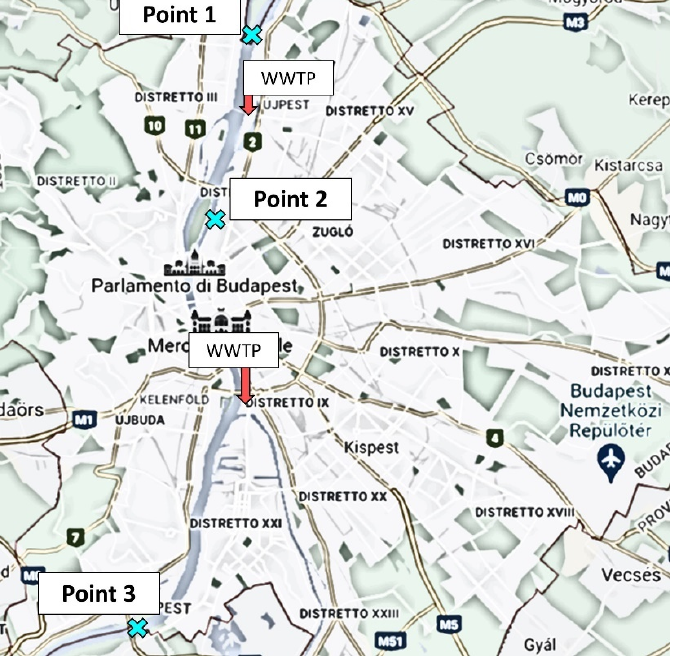
Figure 1. Map showing the location of the sampling points (P1, P2 and P3) and